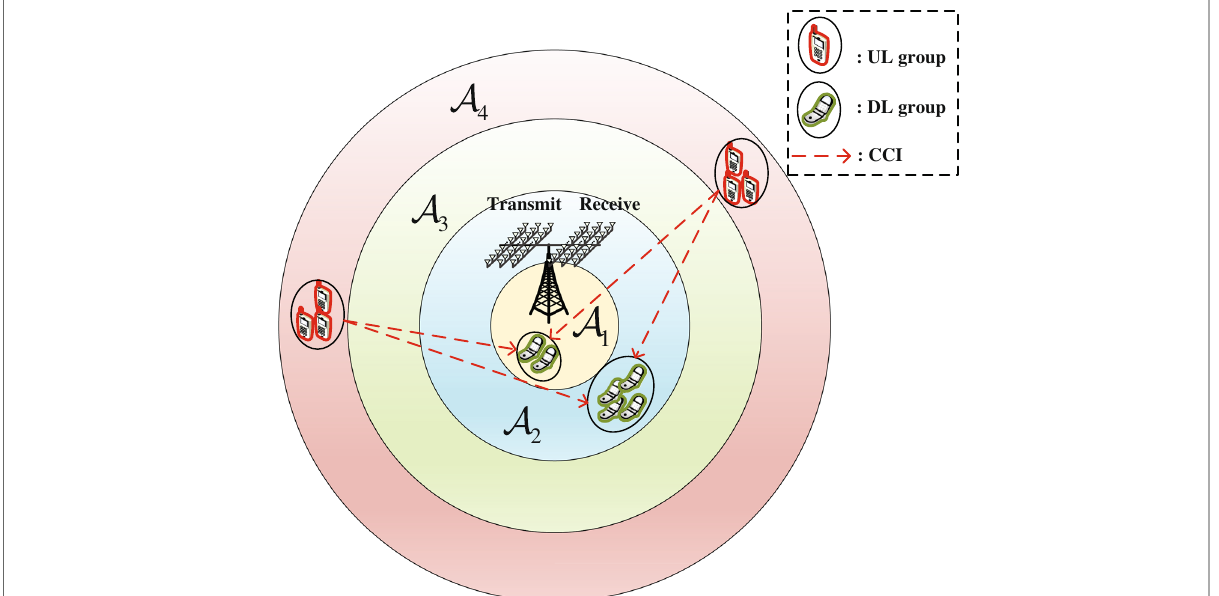
Fig. 3 Illustration of CCI between UL and DL groups under the cell partitioning